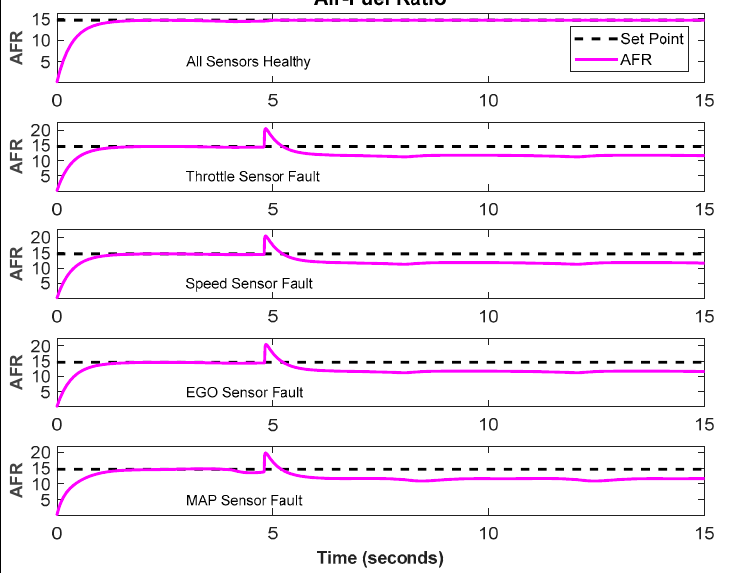
Figure 6. AFTCS performance for AFR control of the IC engine.